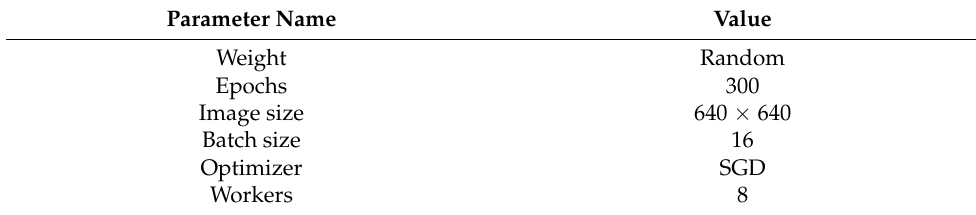
Table 3. Training